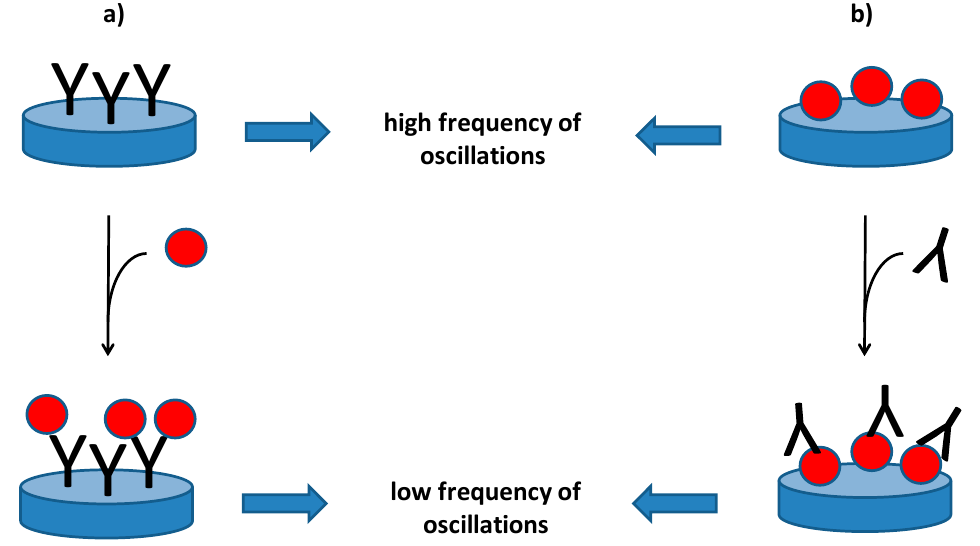
Figure 1. Piezoelectric immunosensors for the determination of an antigen ( a ) or an antibody ( b ). A piezoelectric crystal is depicted as a blue disc. The antibodies are shaped like Y letter because of typical appearance of common immunoglobulins; an antigen is drawn as a red ball.